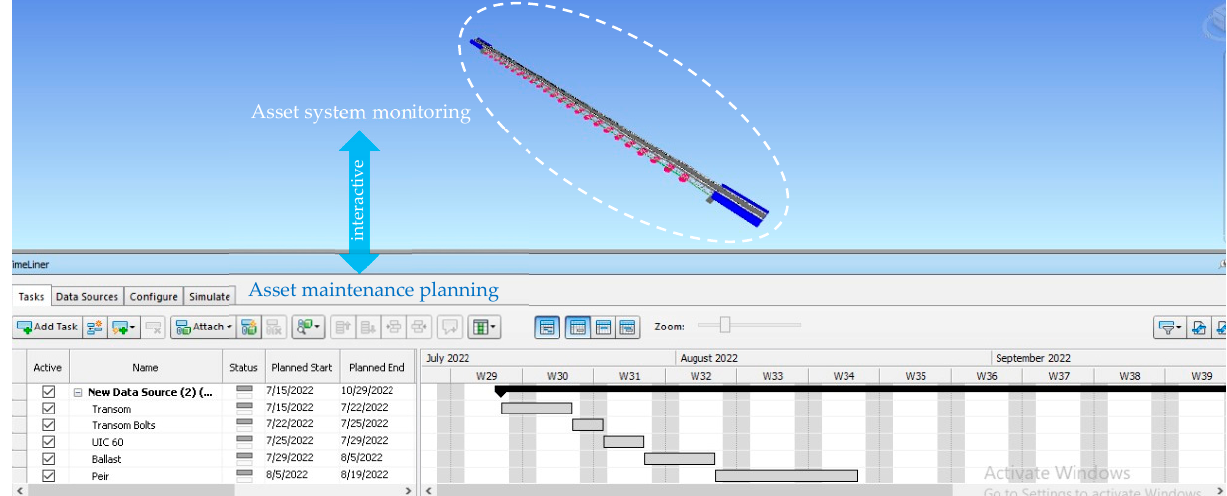
Figure 8. An example of the capability of the BIM-based digital twin to incorporate the timeline maintenance schedule of the Minnamurra Railway Bridge. The BIM-based digital twin can also be further extended to append real-time structural health from live monitoring sensors installed on the bridge.